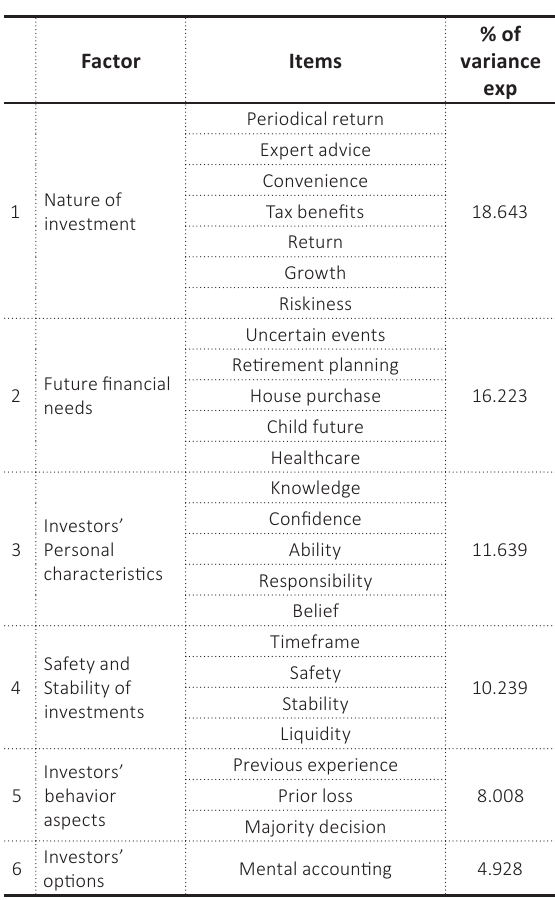
Table 3. Identified factors